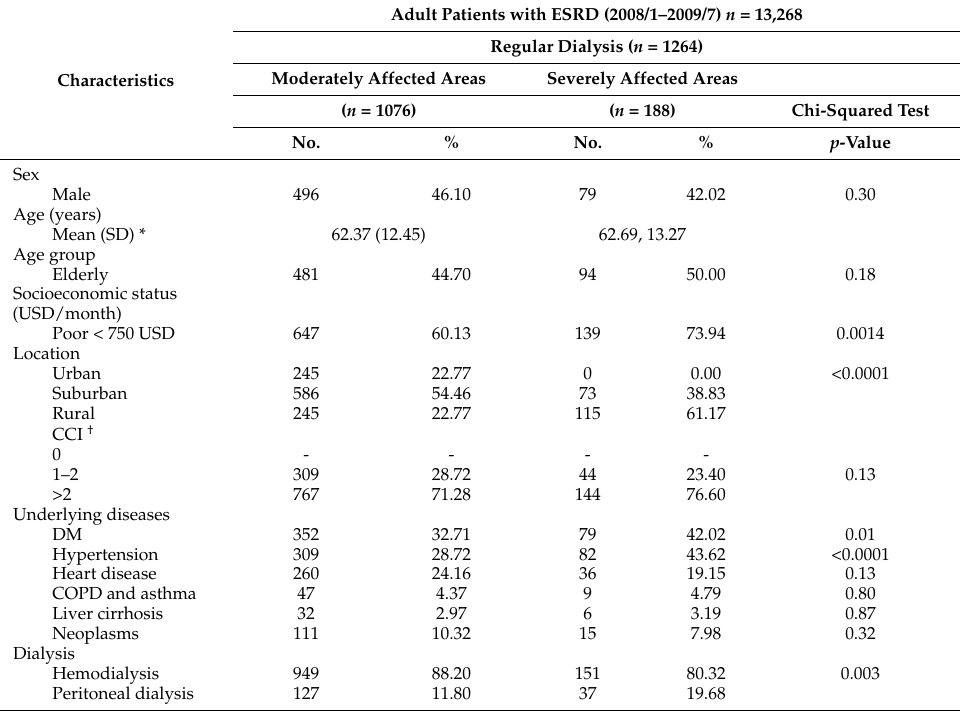
Table 1. Demographic and clinical characteristics of adults with ESRD living in areas affected by Typhoon Morakot to differing degrees of severity.